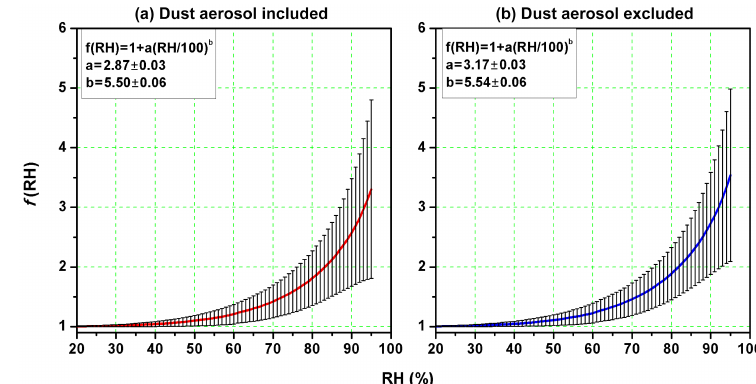
Figure 15. Distribution of the hygroscopic growth curves in